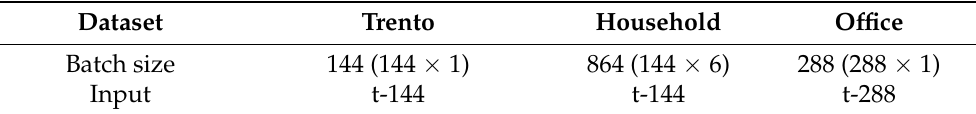
Table 4. Parameters Selection.